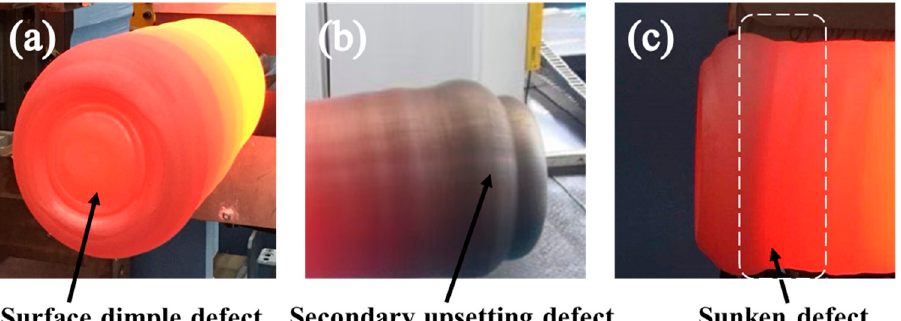
Figure 2. The typical geometric defects formed in the electric upsetting process: ( a ) Surface dimple defect ( b ) Secondary upsetting defect and ( c ) Sunken defect